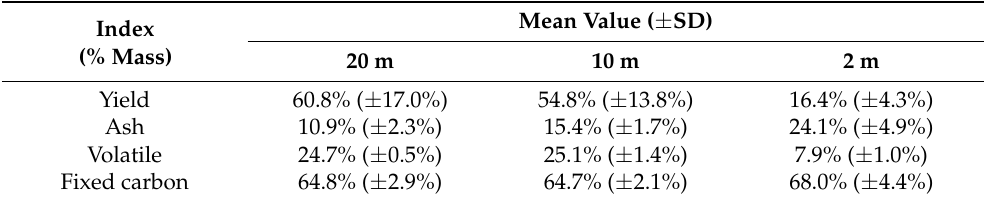
Table 2. Characteristics of beneficiated coal according to the distance from the